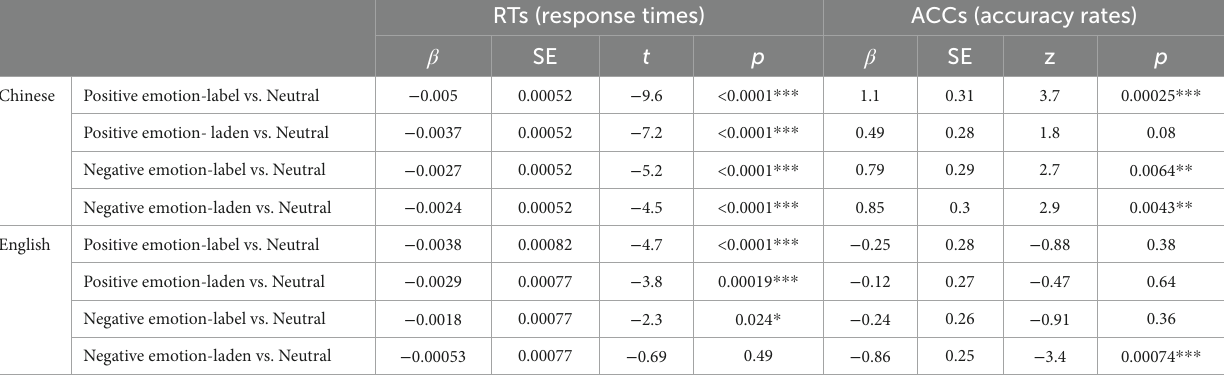
TABLE 4 Statistical analysis of the RTs and ACCs of four groups of emotion words compared to neutral words in L1 (Chinese) and L2 (English).